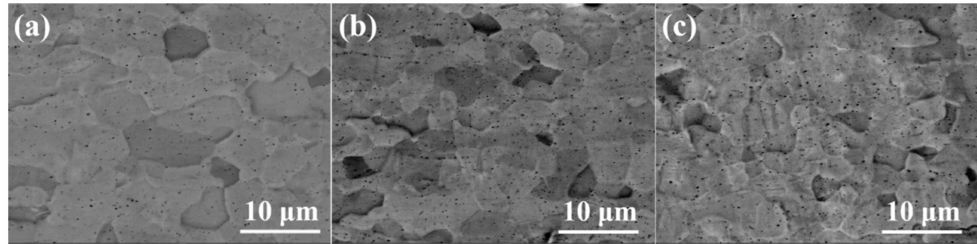
Figure 2. The surface morphology of Cr coating samples: ( a ) 1#, ( b ) 2# and ( c )